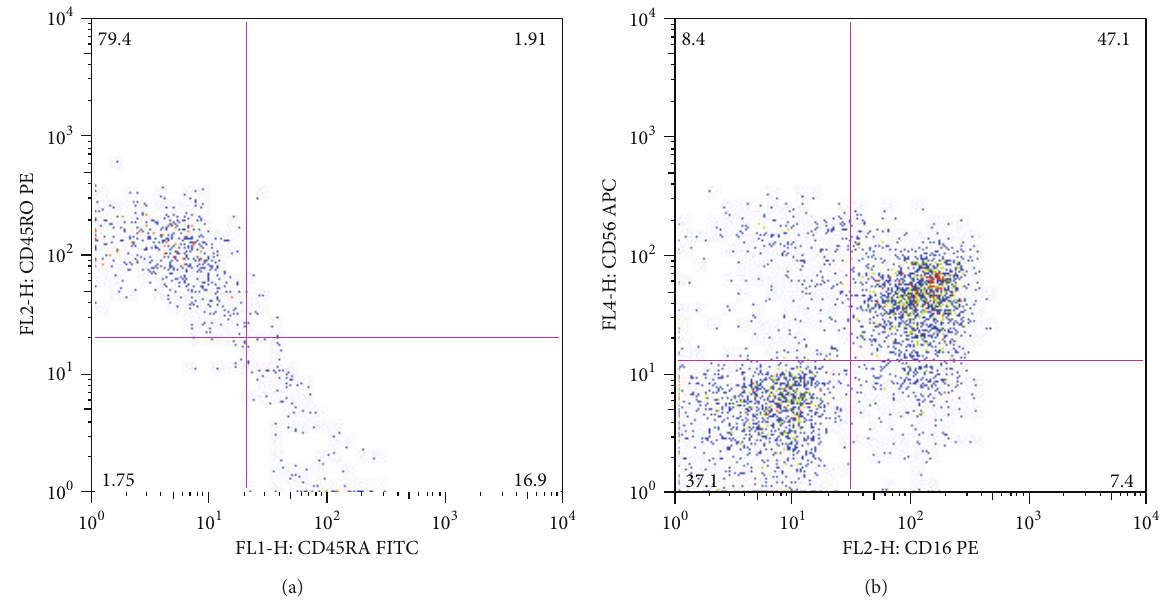
Figure 3: Cytofluorimetric CD45RA/CD45RO ratio (a) and CD16/CD56 + population (b). Note the reduced number of na¨ıve T cells (CD45RA) versus peripheral T cells (CD45RO) (17% versus 80%, resp.) and the prevalent NK population